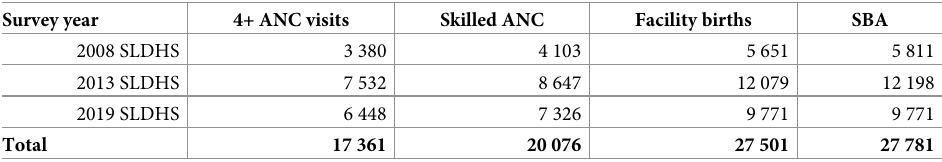
Table 1. Sample used in the